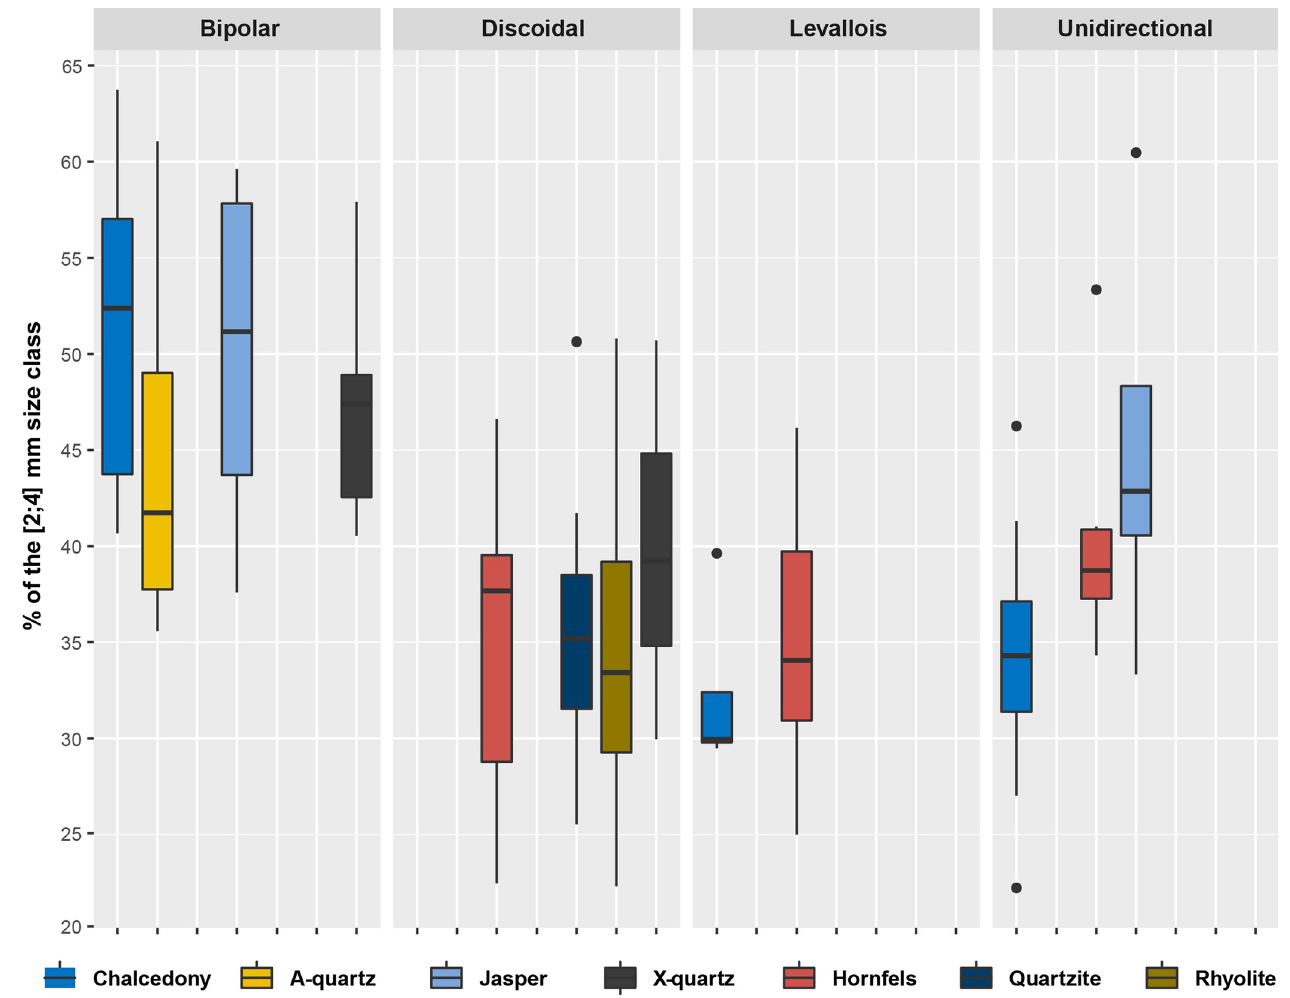
Fig 6. Box plots comparing the proportion of the [2:4] mm size class (counts) depending on the raw material and the knapping